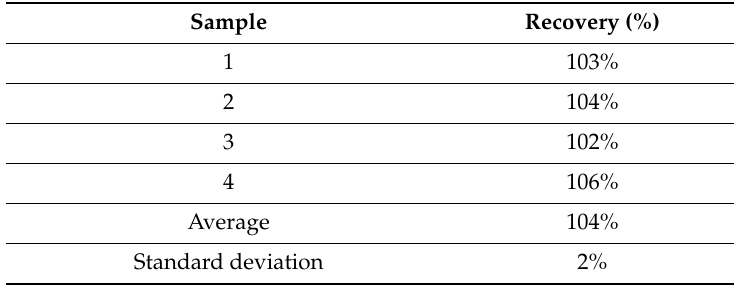
Table 3. Evaluation of the accuracy of the method for the determination of NAR in SFN.